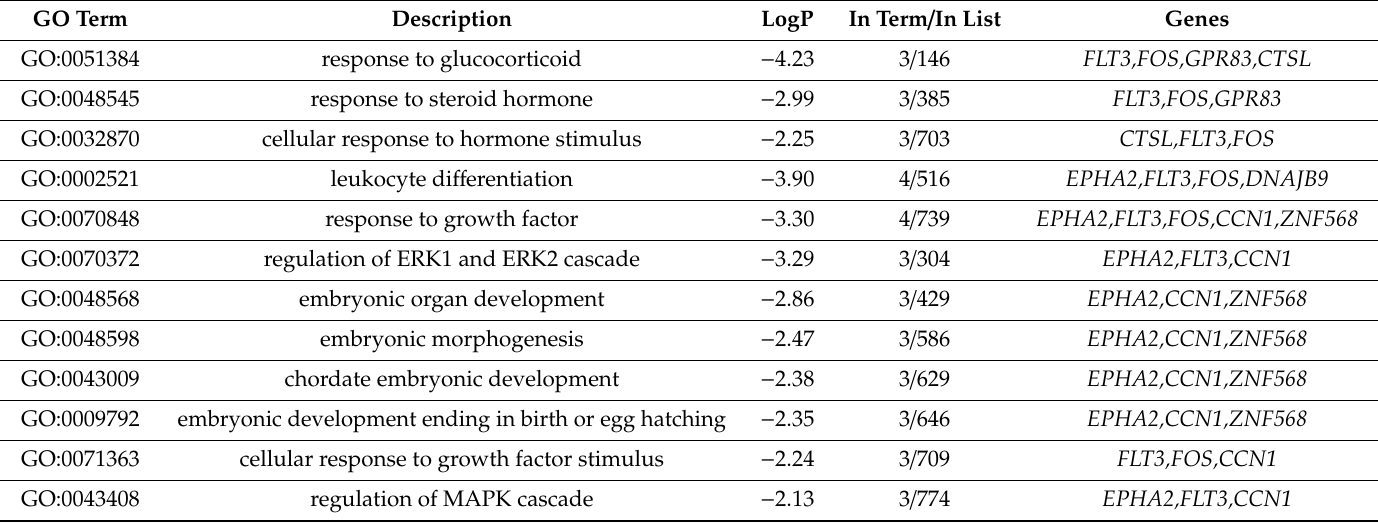
Table 3. Metascape functional annotation clusters for downregulated genes in embryos treated with FeEVs compared to